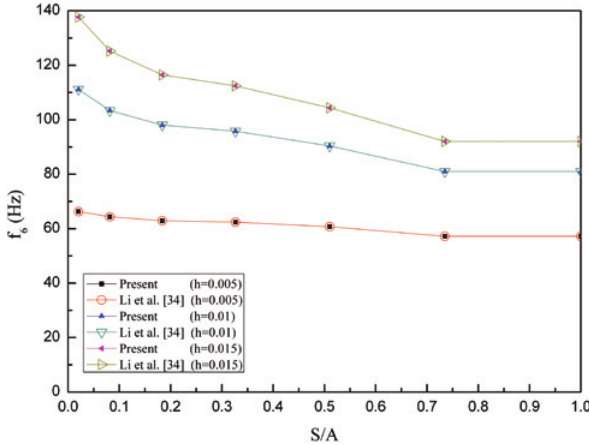
Figure 15 The sixth-order frequency of the clamped square com- posite laminates with different area of bonding imperfections.